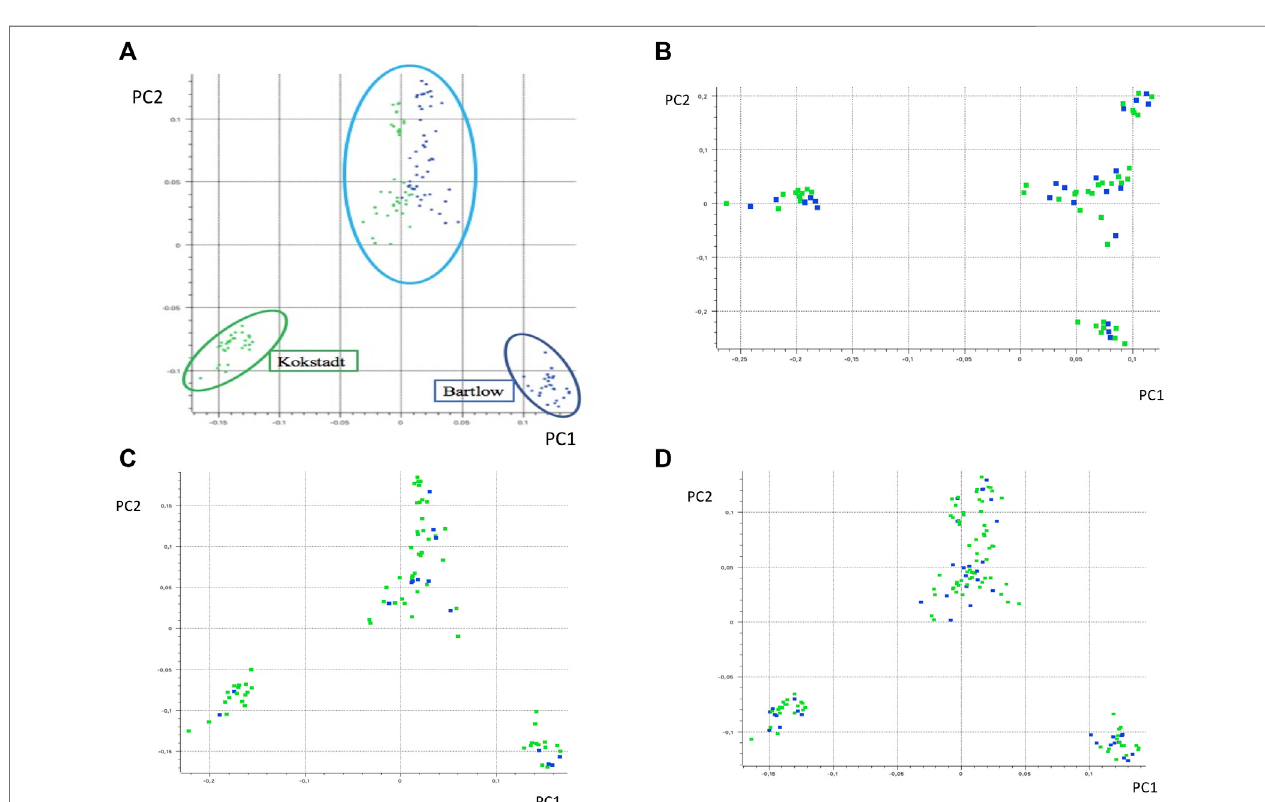
FIGURE 2 | Principal component based clustering of the Nguni cattle (A) from two different farms, Bartlow Combine and Kokstadt conservation stations; (B) phenotyped for base coat colourl (C) phenotyped for absence and presence of forehead strip and (D) phenotyped for colour sidedness or non-colour sidedness. Principal component analysis diagram showing principal component one (PC1) and principal component two (PC2) and the variance depicted alongside the axes of the diagram.